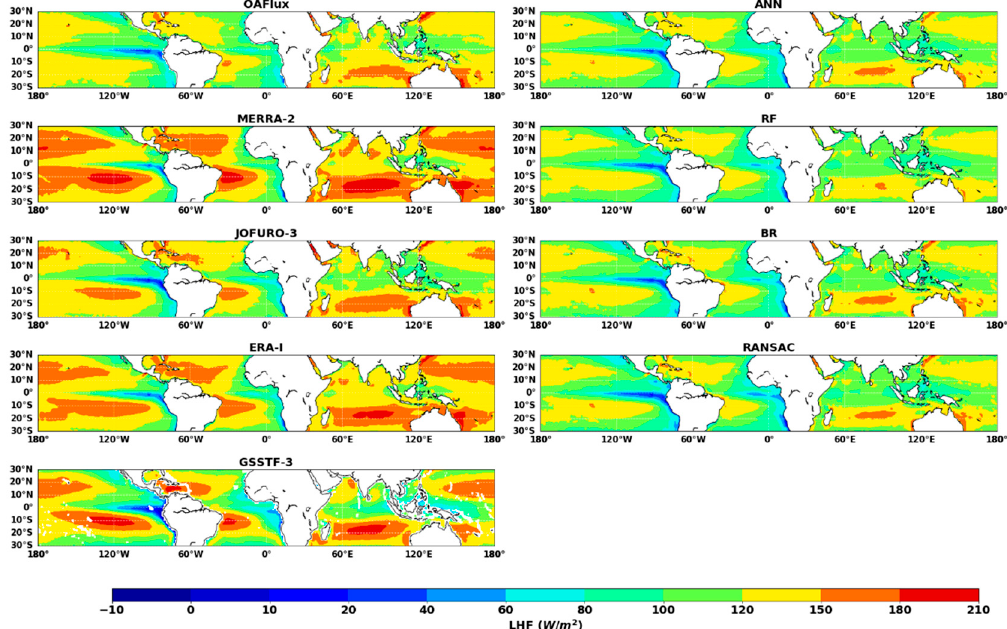
Figure 9. Maps of multi-year (2003-2007) annual average ocean LHF . The first column (left) presents the maps of ocean LHF from OAFlux , MERRA-2 , JOFURO-3 , ERA-I and GSSTF-3 . The second column presents the maps of ocean LHF using ANN , RF , BR and RANSAC (unit W m − 2 ).